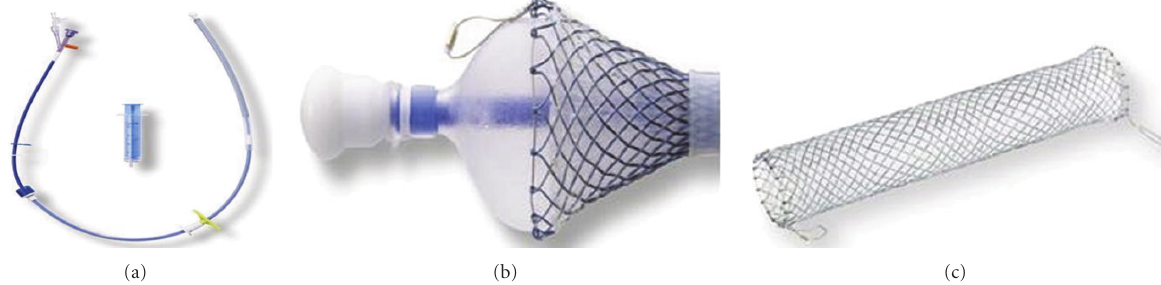
Figure 1: (a) The SX-Ella DANIS stent is supplied preloaded in an insertion device that has a 26 F diameter and is 60cm long. (b) A balloon at the distal end of the insertion device (shown partially inflated) allows anchoring of the distal end of the stent at the cardia during deployment. (c) The fully deployed stent is 135 mm long and 25mm wide [Reprinted from [21]].